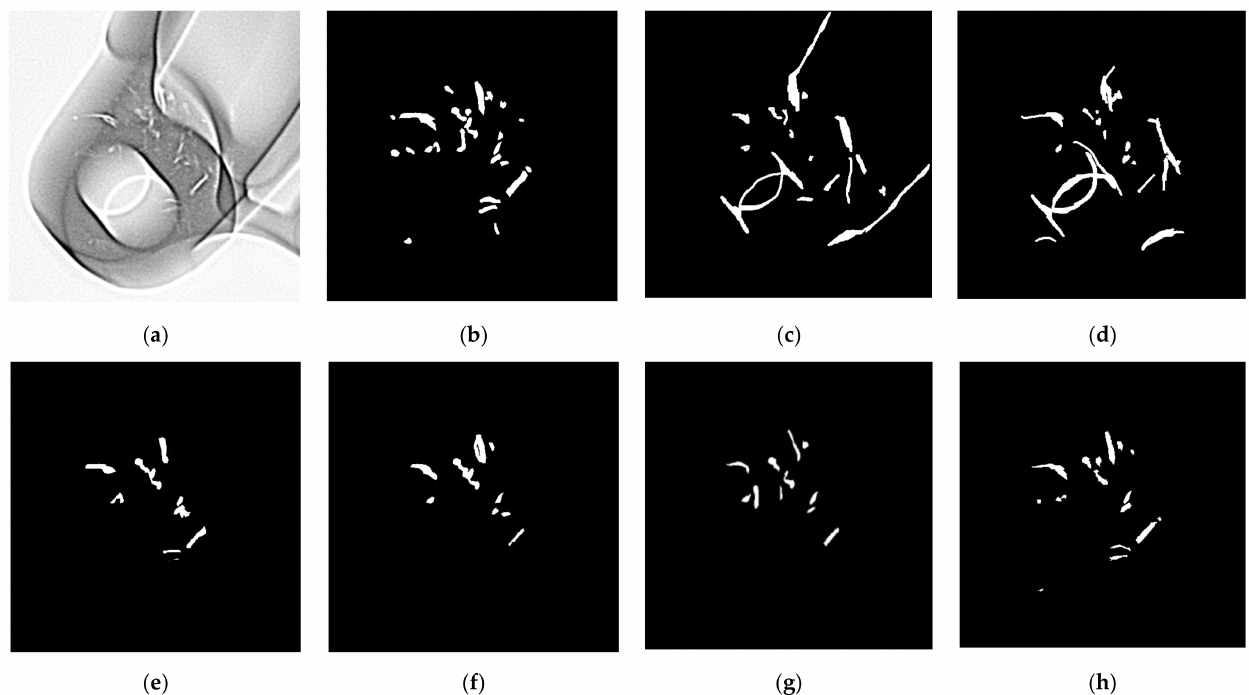
Figure 10. A typical example of defect segmentation: ( a ) the original image, ( b ) ground-truth image, ( c ) result of median and morphological filters, Reference [3], ( d ) result of a traditional defect detection algorithm, Reference [4], ( e ) result of Mask R-CNN, ( f ) result of UNet, ( g ) result of standard UNet++, ( h ) result of proposed method.